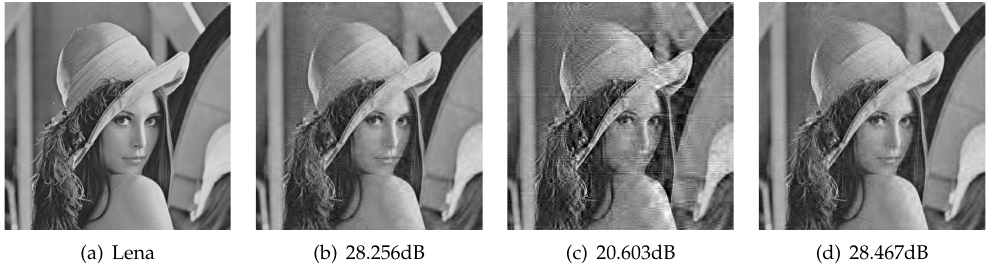
Figure 10. The reconstruction results of the standard test image Lenna at τ = 0.4. ( a ) original image; ( b ) reconstructed by HTP with α ∗ = 5.5, (PSNR: 28.256 dB); ( c ) reconstructed by CGIHT (PSNR: 20.603 dB); ( d ) reconstructed by CGHTP (PSNR: 28.467 dB).